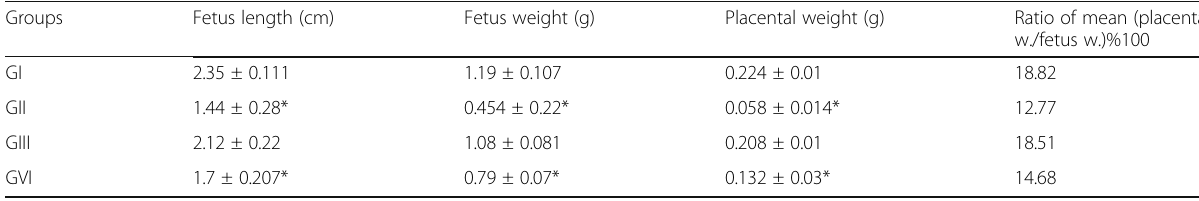
Table 2 Effects of olive leaf extract and/or STZ administration on the fetal length, fetal weight, placental weight, and the ratio of placental/fetus weight at gestation day 18 Groups